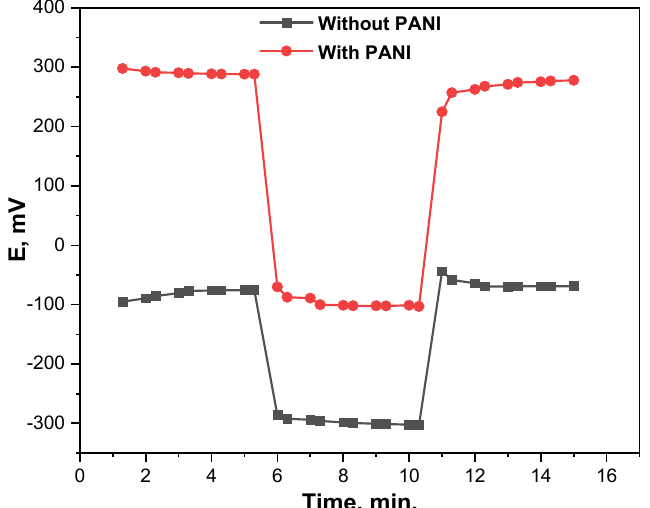
Figure 5. Layer effect on the response of the MIP-based MB microchip (10 − 4 mole L − 1 ) with and without PANI.